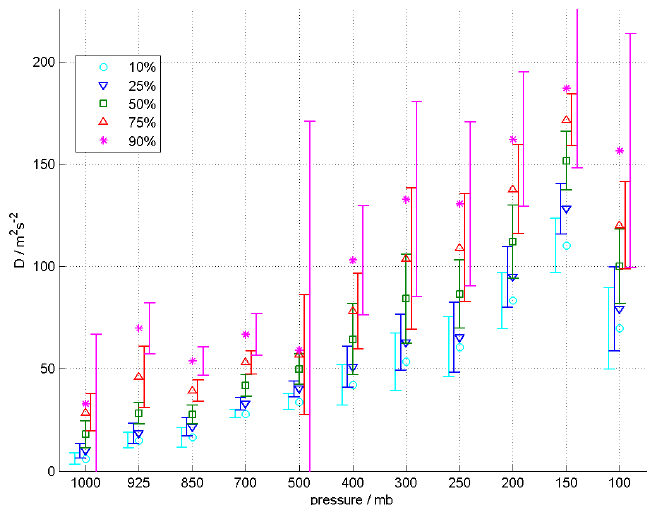
Figure 9. Results and vertical profile for the coefficient D at the five percentiles: 10%, 25%, 50%, 75%, and 90%. The error bars shown are for the 98% confidence interval.